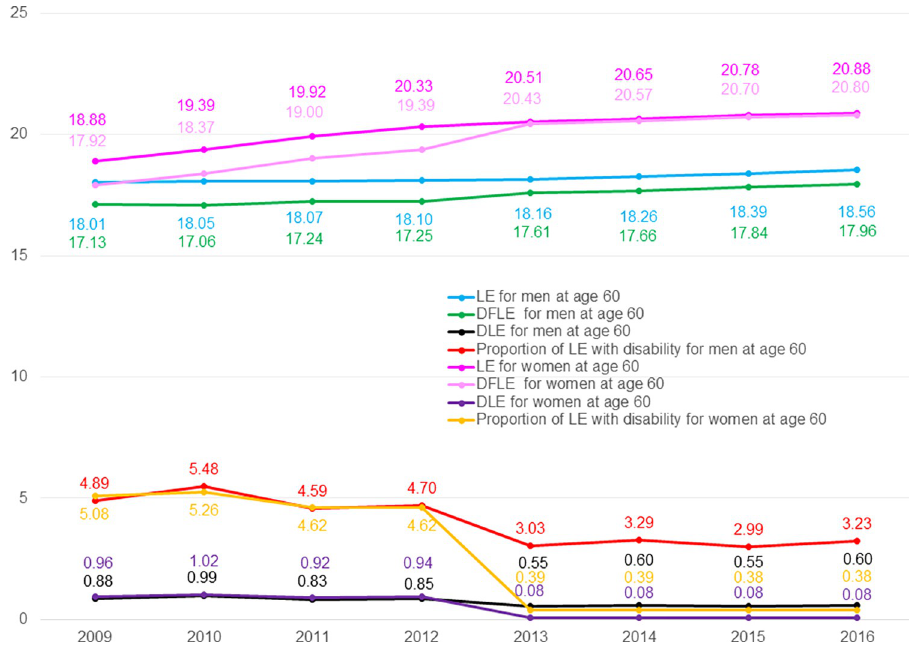
Fig 4. Trends in health expectancy at age 60 from 2009 to 2016. Notes: DFLE: Disability-free life expectancy; DLE: Life expectancy with disability; LE: Life expectancy.